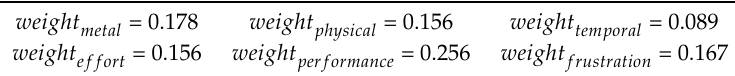
Table 3. The weighted scores from NASA-TLX survey